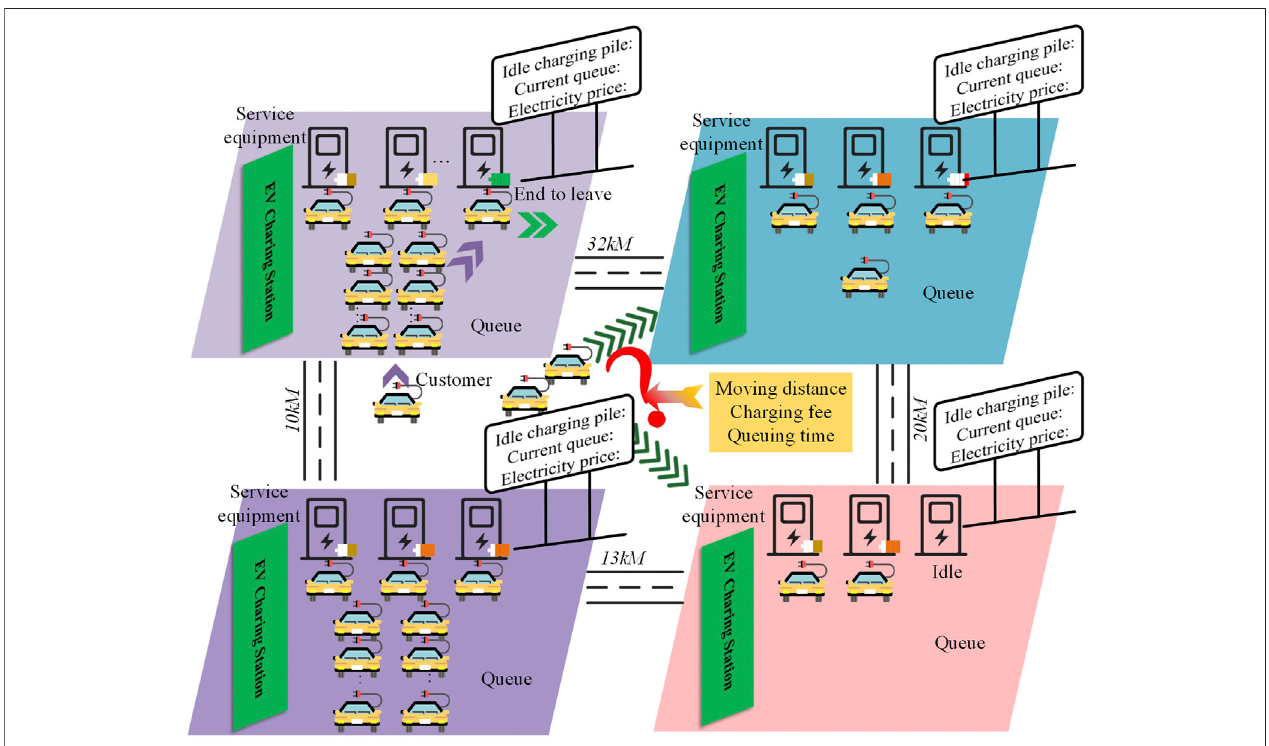
FIGURE 3 | Schematic diagram of the PHEV mobile charging